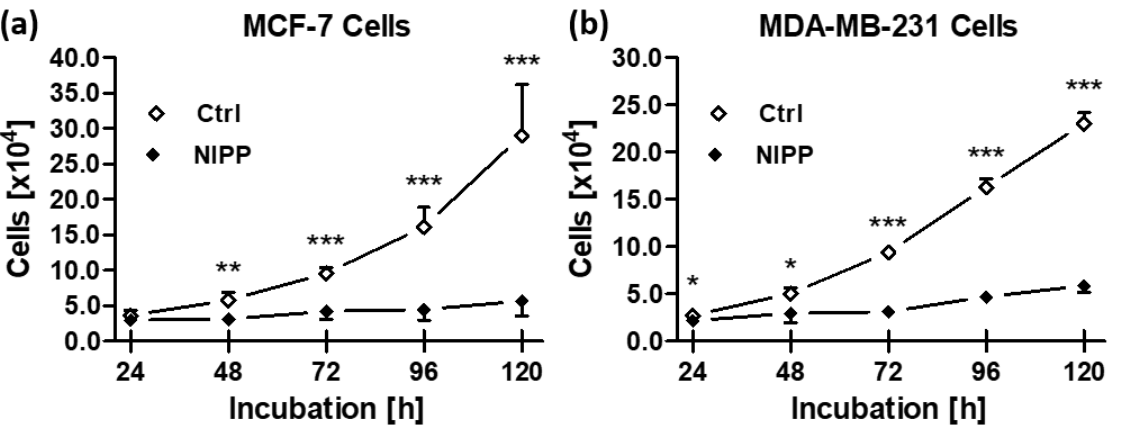
Figure 8. Cell growth assay. Breast cancer cells MCF-7 ( a ) and MDA-MB-231 ( b ) were treated with NIPP for 20 s, incubated for 120 h at 37 ◦ C and 5% CO 2 , and live-cell numbers were determined at the indicated time points (CASY Cell Counter and Analyzer model TT). The results are displayed as mean ± standard deviation ( p ≤ 0.05 *; p ≤ 0.01 **; p ≤ 0.001 ***).